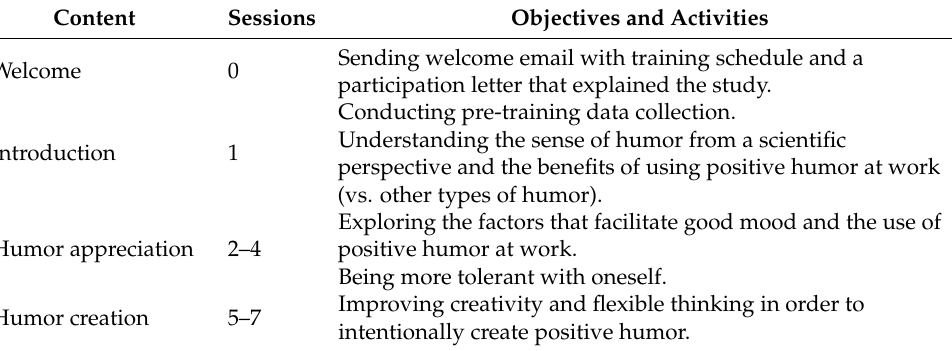
Table 1. Contents of the